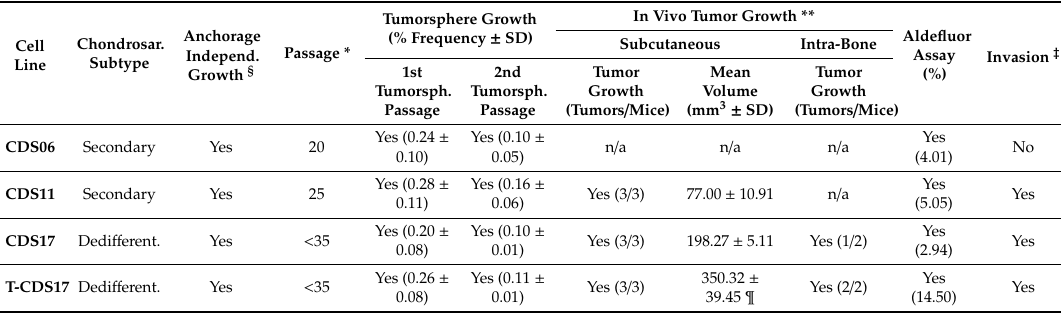
Table 1. Functional characterization of chondrosarcoma cell